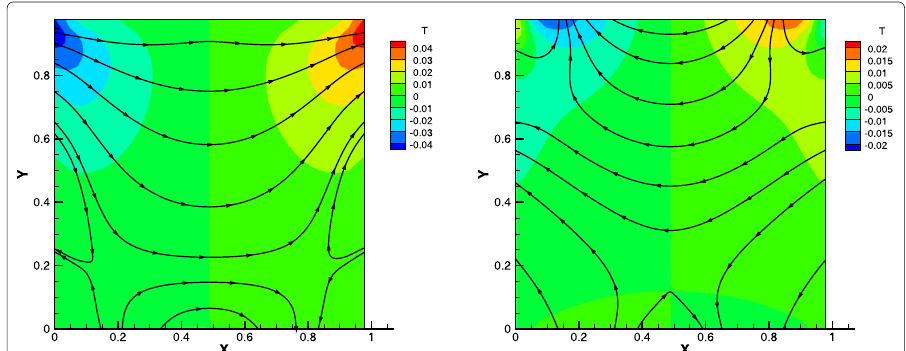
Fig. 18 The heat flux and temperature contour of the lid-driven cavity flow with Knudsen number 0.1. Left figure shows the UGKS solution and right figure shows the Navier-Stokes solution